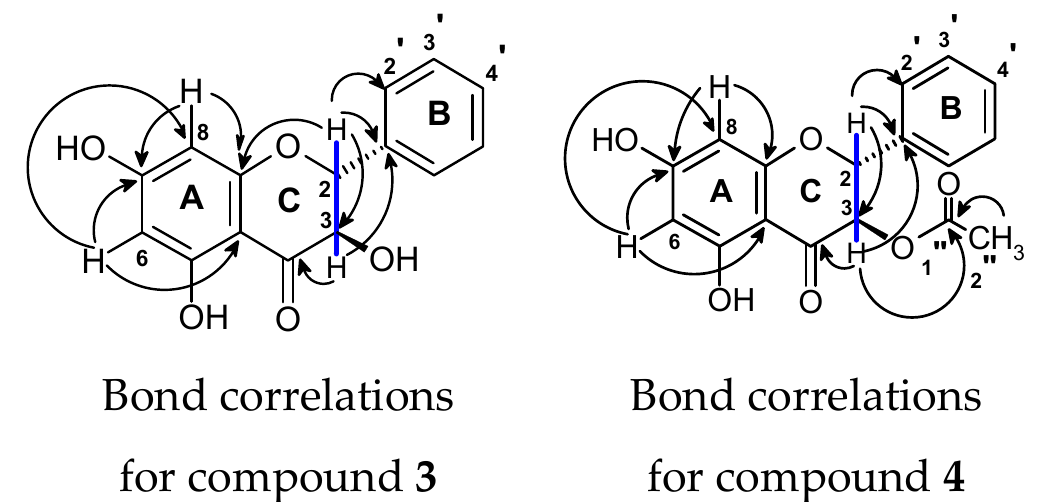
Figure 2. Key heteronuclear multiple bond correlations ( → ) and homonuclear correlations (—) in compounds 3 and 4 interpreted from 2-D NMR.